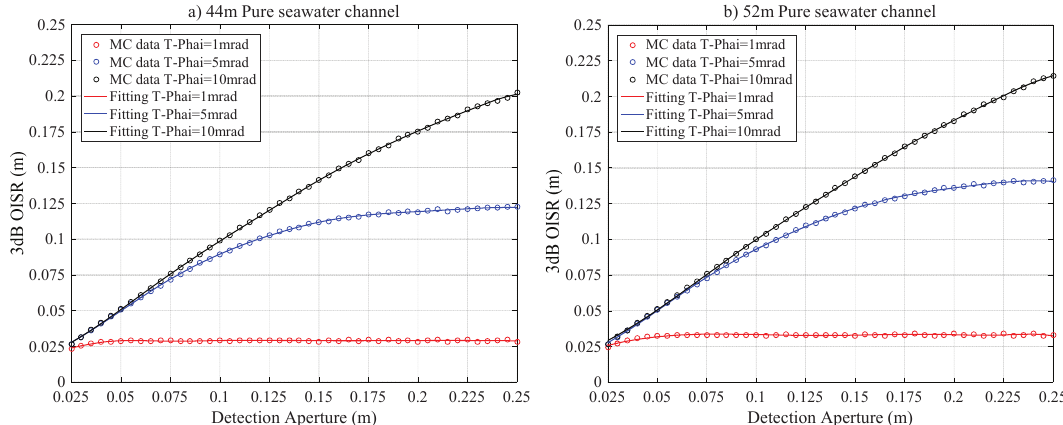
Figure 3. The r 3 dB versus R PD for pure seawater laser channel for a link distance of ( a ) 44 m and ( b ) 52 m.